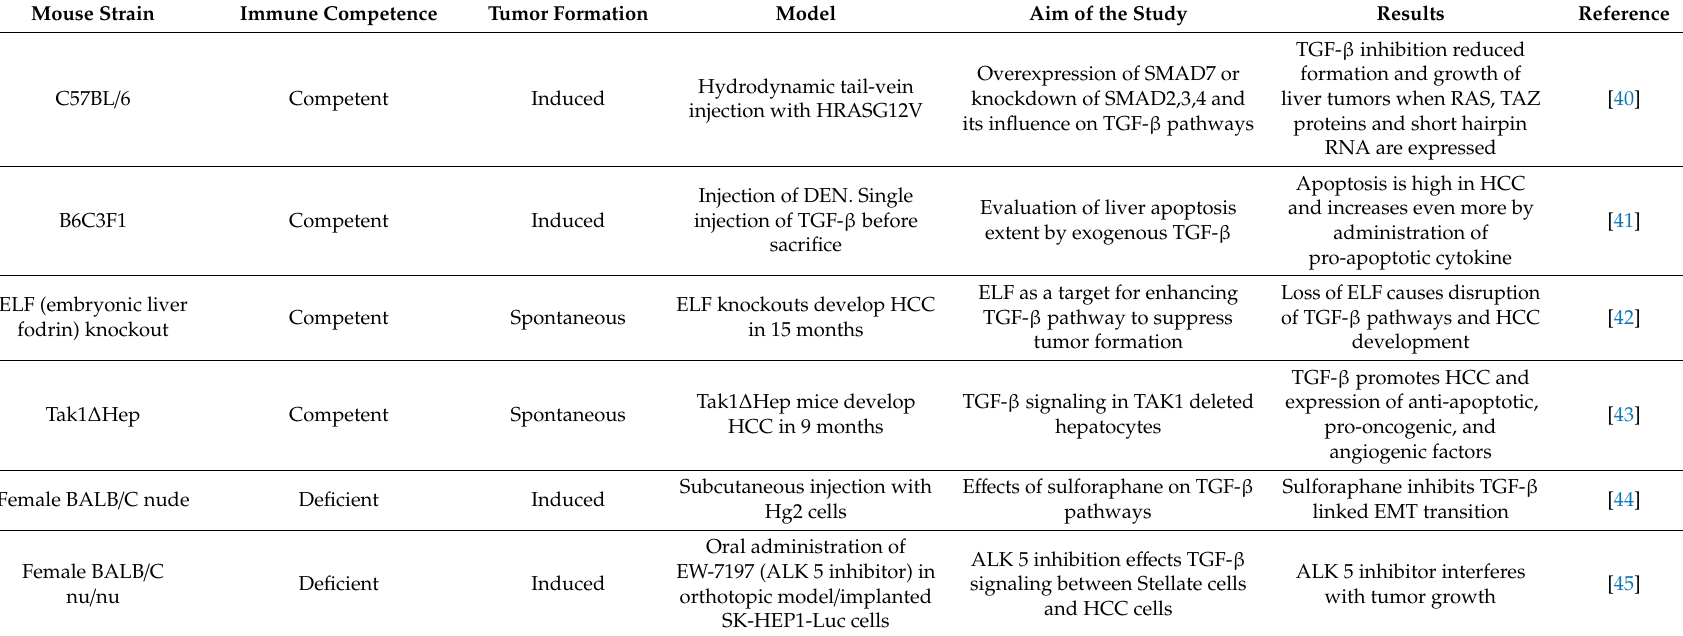
Table 1. Animal models for the role of transforming growth factor beta in hepatocellular